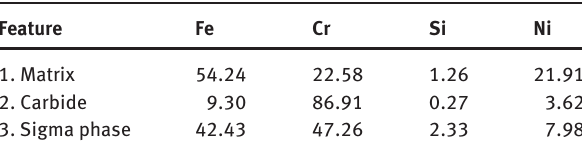
Table 1: Electron probe microanalysis (EPMA) results of three phases in wt.% [1].